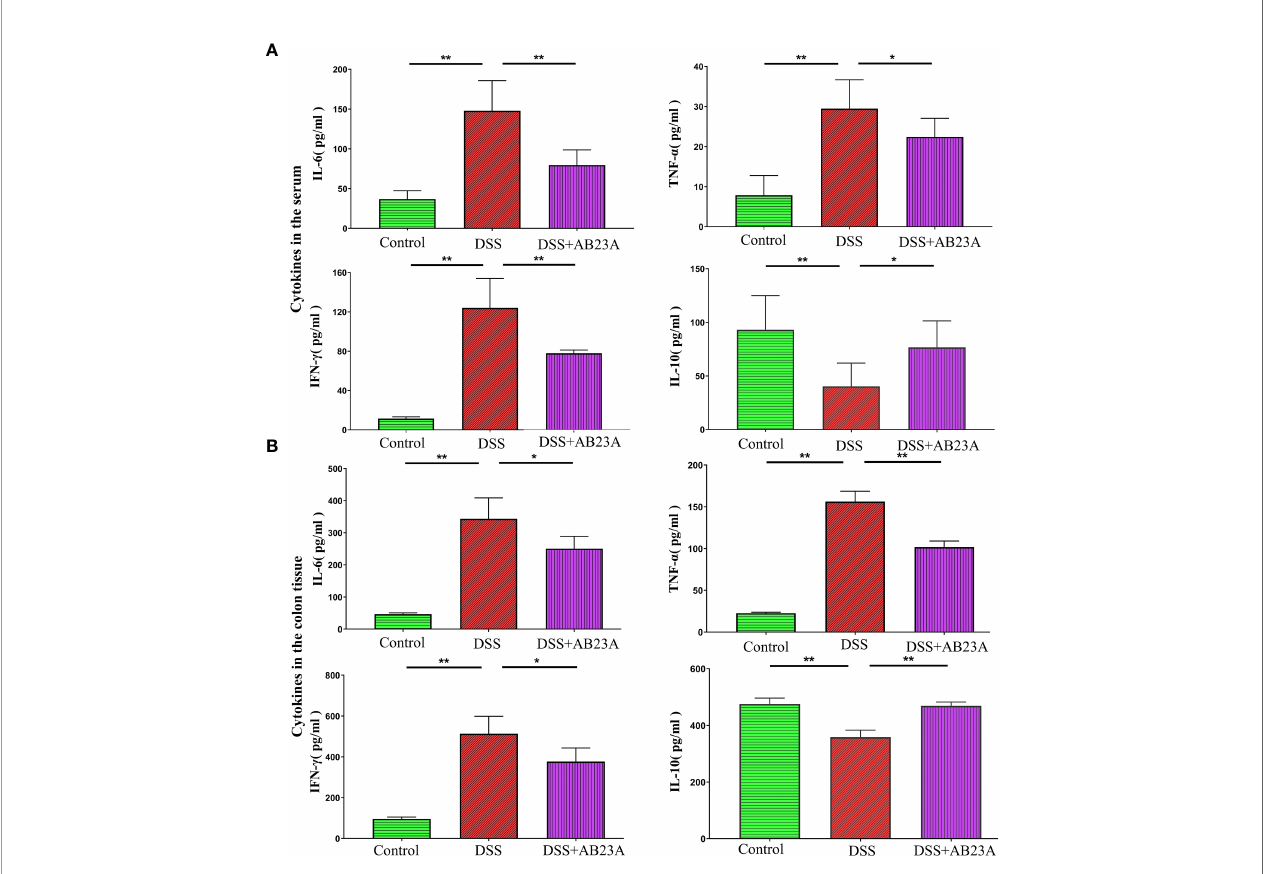
FIGURE 2 | Effects of AB23A on serum levels of cytokines in serum and colon tissue. (A) The expression of IL-6, TNF- a , IL-10, and IFN- g in serum. (B) The expression of IL-6, TNF- a , IL-10, and IFN- g in colon tissue. Data are expressed as mean ± SD (n = 8 in the serum and n = 4 in colon tissue). Differences were analyzed by one-way ANOVA followed by Tukey ’ s post hoc test (*P < 0.05, **P <